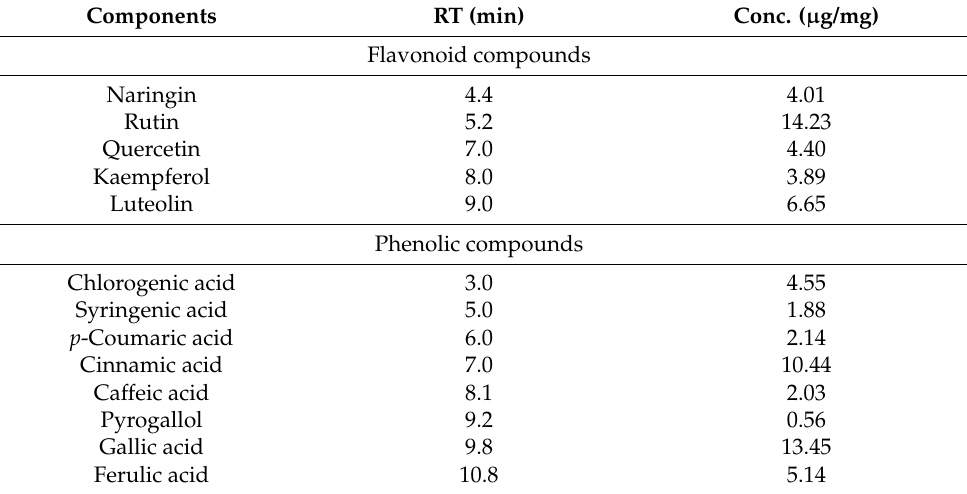
Table 5. HPLC analysis results of the